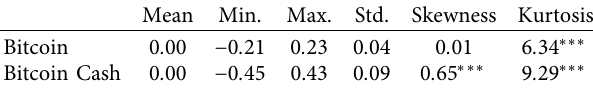
Table 1: Descriptive statistics of daily log